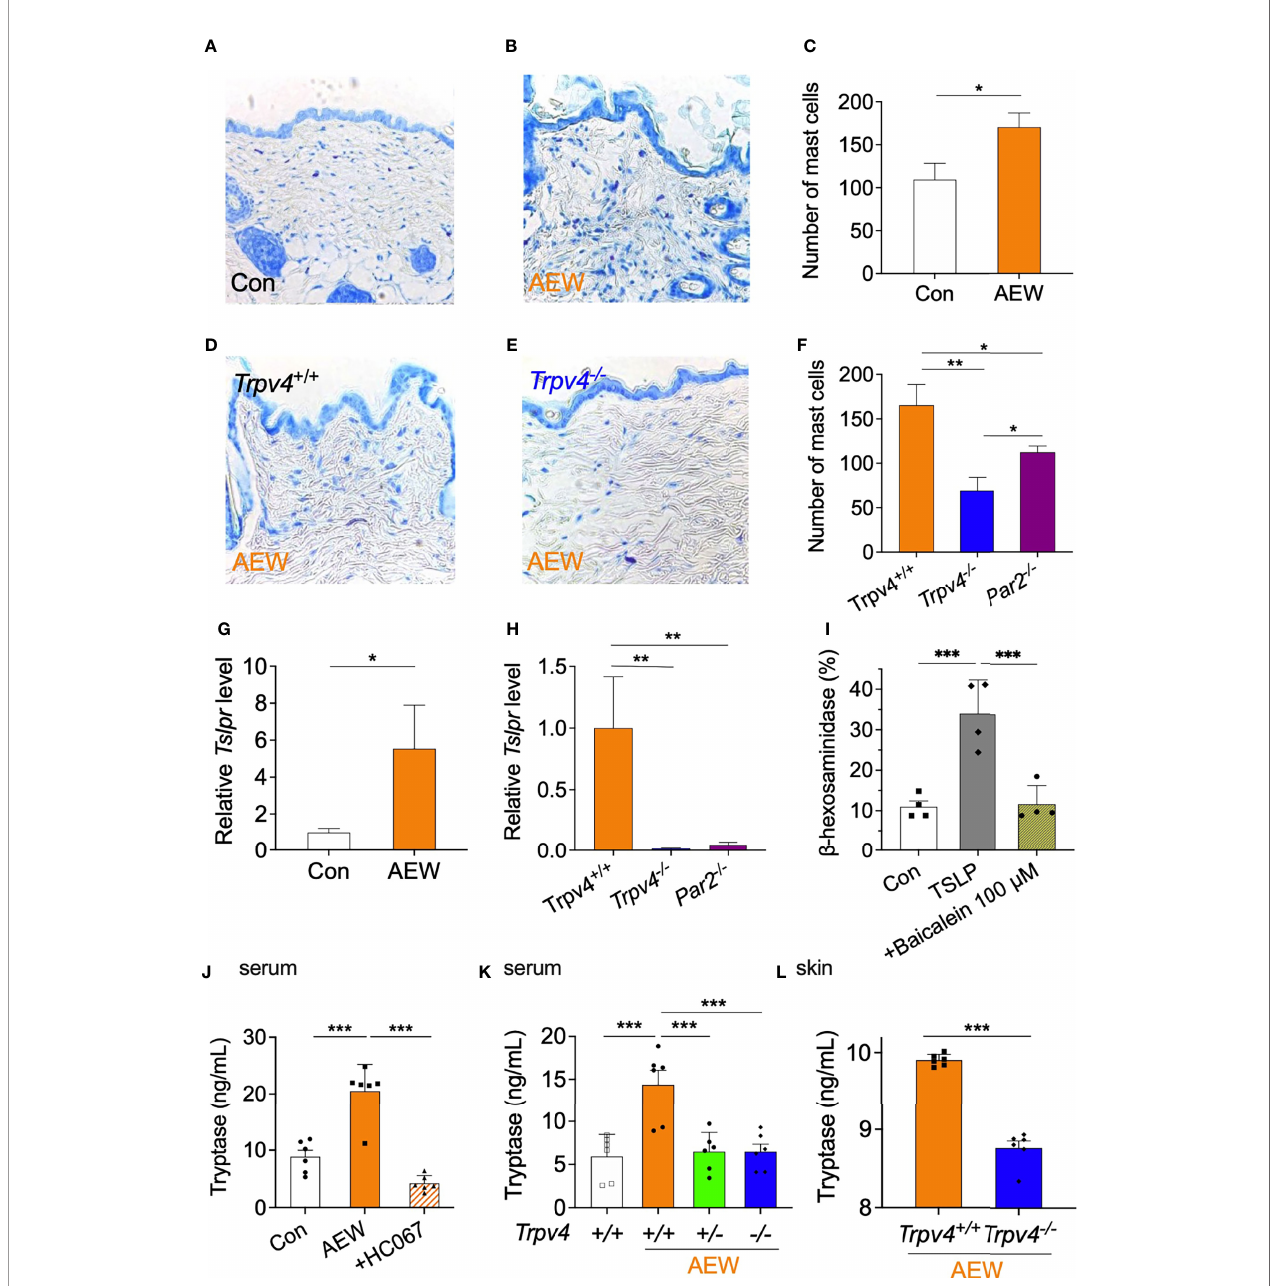
FIGURE 6 | The TRPV4-mediated production of TSLP affects the increased proliferation and degranulation of mast cells. Representative toluidine blue-stained images of the skin tissues of the control (A) and AEW-treated mice (B) . (C) The number of mast cells signi fi cantly increased in the skin tissues of AEW-treated mice (n = 3 per group). Representative toluidine blue-stained images of the skin tissues of AEW-treated Trpv4 +/+ (D) and Trpv4 -/- mice (E) are depicted. (F) Comparison of the number of mast cells in Trpv4 +/+ , Trpv4 -/- , and Par2 -/- mice (n = 3 per group). The number of mast cells was lowest in the Trpv4 -/- mice following treatment with AEW. (G) The transcriptional levels of Tslpr were signi fi cantly increased in the mast cells of AEW-treated mice (n = 3 per group). (H) The transcriptional levels of Tslpr were not elevated in the mast cells of Trpv4 -/- and Par2 -/- mice (n = 3 per group). (I) Treatment with TSLP induced mast cell degranulation, as revealed by measuring the release of b -hexosaminidase. Mast cell degranulation was inhibited by baicalein, a TSLPR inhibitor (n = 4 per group). (J) The serum levels of tryptase were elevated in the AEW mice, and were signi fi cantly reduced when the TRPV4 antagonist, HC067047, was administered during AEW treatment (n = 6 per group). (K) The serum levels of tryptase were signi fi cantly reduced in both the AEW-treated Trpv4 +/- mice and Trpv4 -/- mice (n = 6 per group). (L) The tryptase levels in the skin tissues of AEW-treated Trpv4 -/- mice were lower than those of the AEW-treated Trpv4 +/+ mice (n = 6 per group). * p < 0.05, ** p < 0.01, *** p <